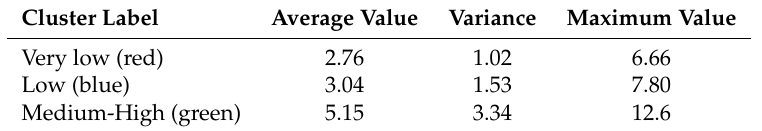
Table 4. Fuel consumption (L/100km) parameters of the three-cluster classification.